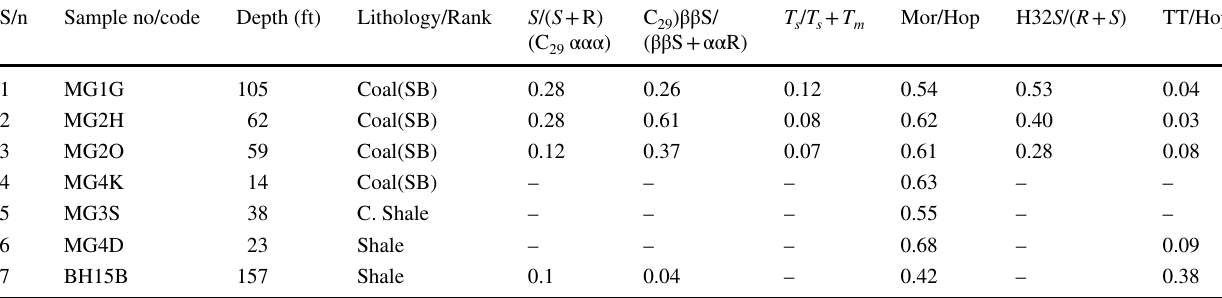
T s / T s + T m = Trisnorhopane, Mor/Hop = moretane/hopane, TT/Hop = tricyclic terpane/hopane, H32 S /( R + S ) = homohopanes, S /( S + R )(C29 ααα), C29)ββS/(ββS + ααR), SB